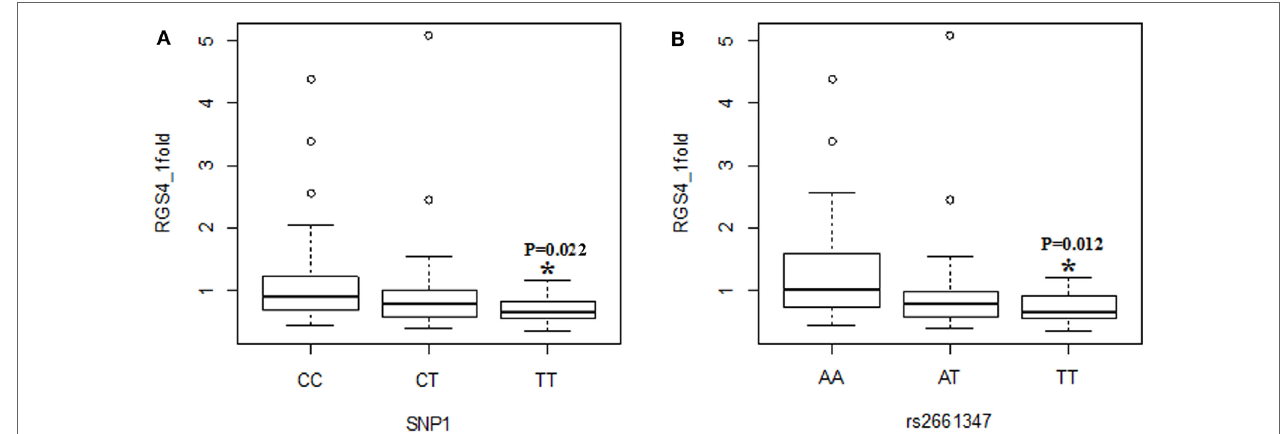
FigUre 2 | effects of snP1 and rs2661347 on RGS4-1 mrna expression levels . RGS4-1 mRNA expression level in genotype TT of SNP1 was significantly lower than that of the genotype CC [ F (3,77) = 4.20, overall p = 0.0083, SNP1 genotype p = 0.0263] (a) . The genotype TT of rs2661347 had significantly lower